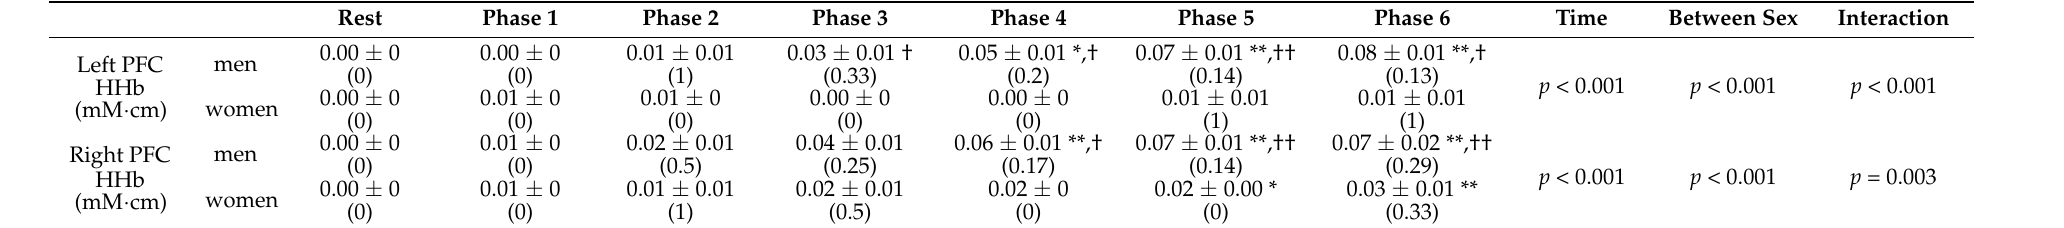
Table 3. Changes in PFC HHb during exercise.